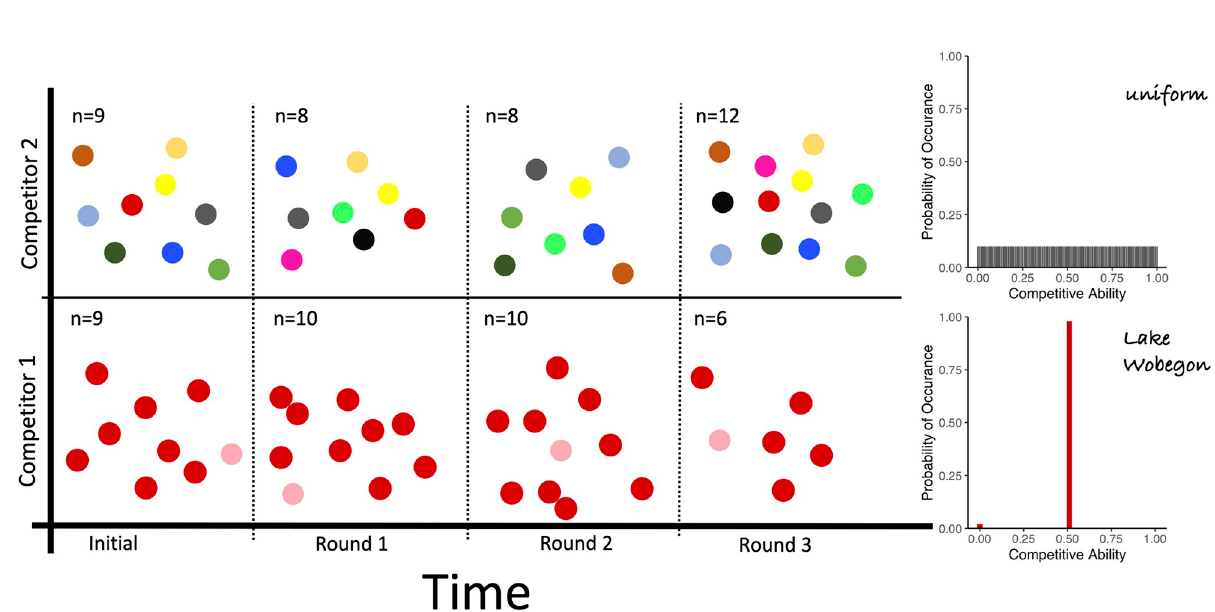
Fig 5. Phenotypic heterogeneity co-exists with the strategy that defeats invariant. In the same type of three time-step competition as in Fig 4, the Lake Wobegon strategy that defeats invariant coexists with an equilibrium strategy (top, multicolored). Note the rainbow color range for the equilibrium strategy reflects its maximal phenotypic